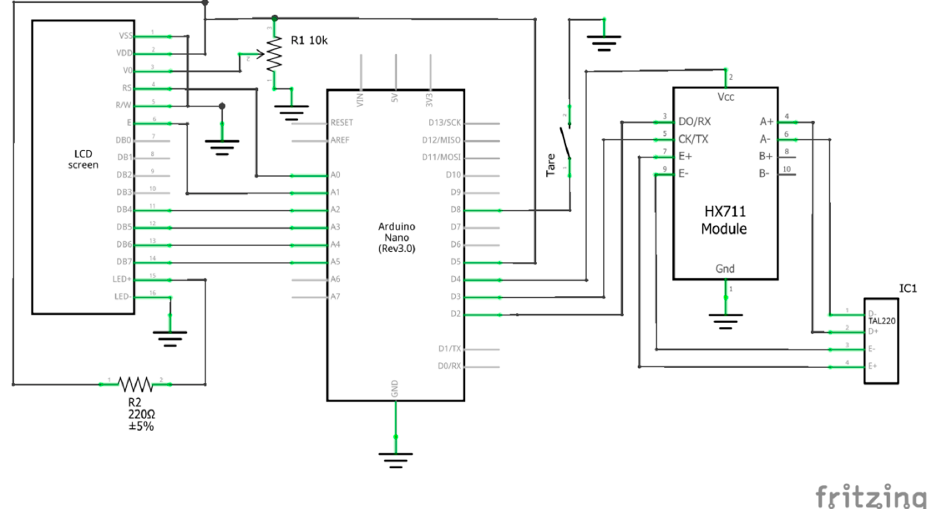
Figure 2. Electrical circuit wiring diagram. Pinouts on the Arduino were selected to reduce the number of required jumper wires when using an Arduino Nano. Pinout selection can be modified in the firmware header file, Pinouts.hpp. Changing micro-controllers or pinouts may change the header